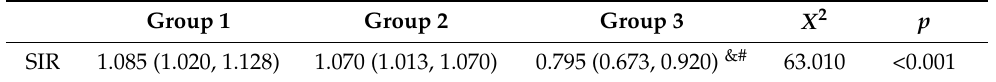
Table 3. Comparison of SIR values among three groups by Kruskal–Wallis test.